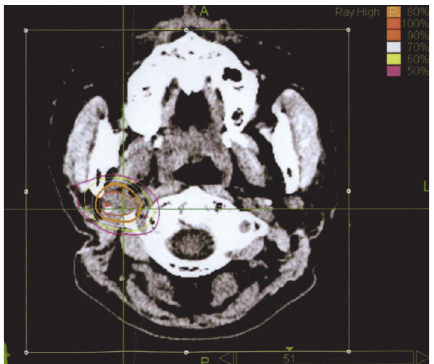
Figure 3: Dose distribution for the lymph node metastasis in the right parapharyngeal region. The planning target volume is illustrated by the thin orange